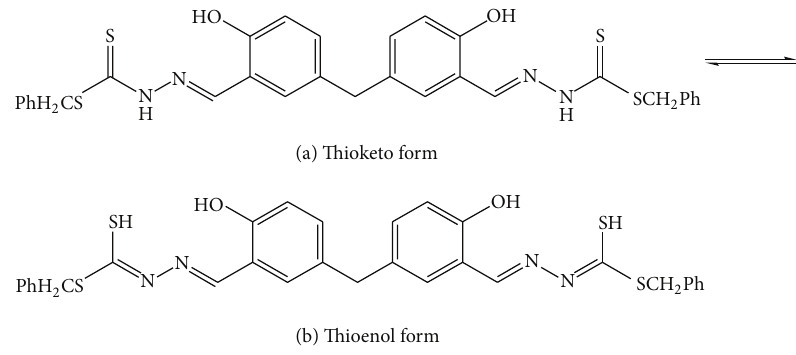
Scheme 1: Tautomeric forms of the Schiff base